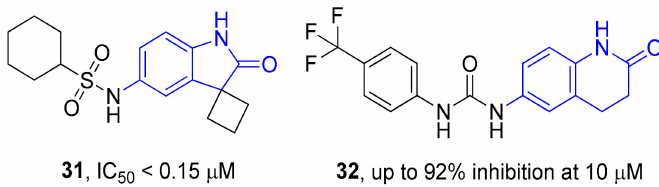
Figure 6. Known BRD4 inhibitors—analogs of the series identified in this